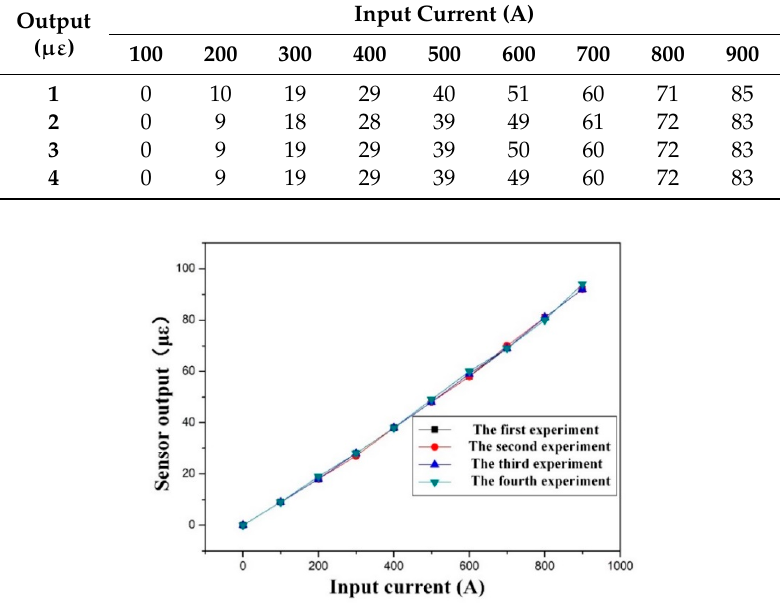
Table 2. Sample data for the repeatability test.